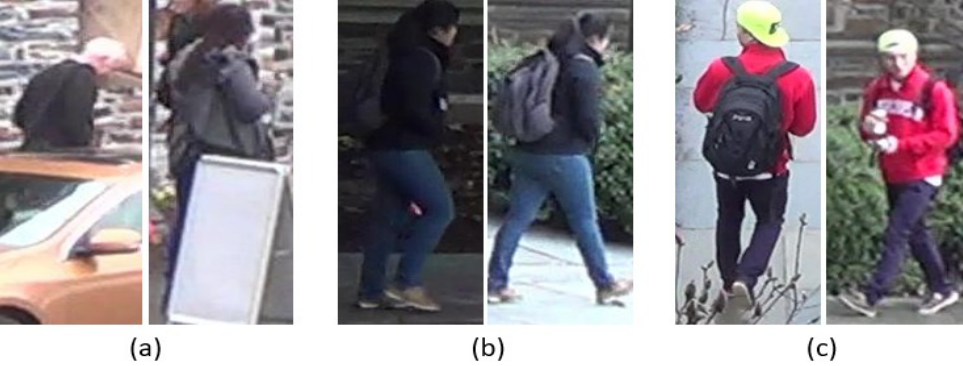
Figure 1. Some difficult issues within the DukeMTMC dataset. ( a ) Occlusions, ( b ) illumination differences, ( c ) pose